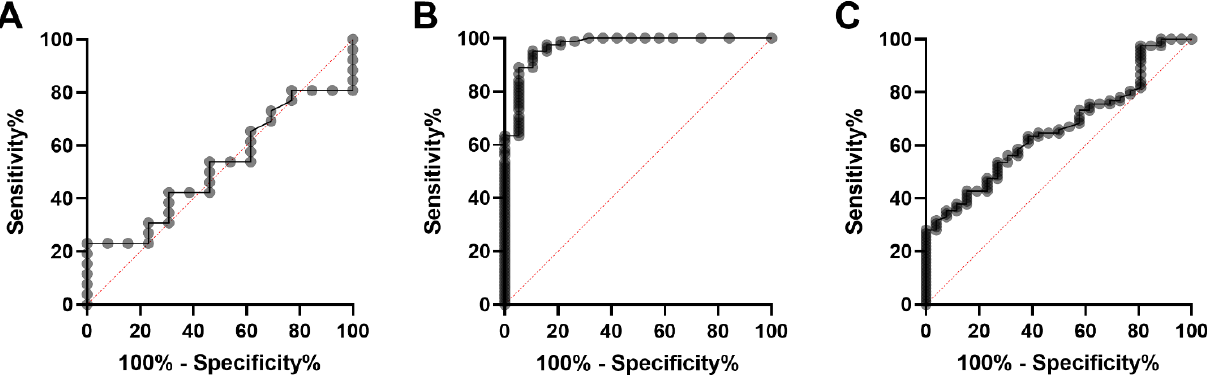
Figure 9. ROC curve analysis of serum Ki-67 concentration. ( A ) ROC curve for discriminating mammary adenocarcinoma from mammary adenoma. ( B ) ROC curve shown to distinguish healthy dogs from patient with tumour diseases. ( C ) ROC curve for discriminating non-malignant diseased dogs from tumour patients.